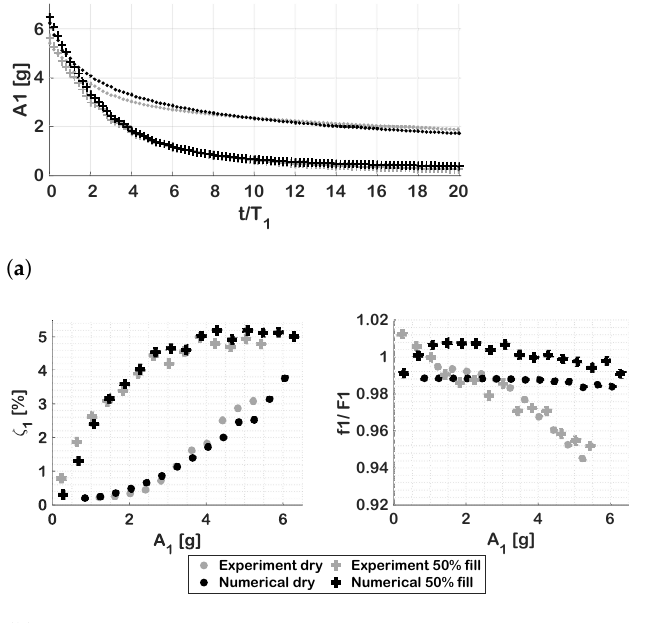
Figure 15. Comparison between experimental and numerical amplitude, frequency and damp- ing ratio of the first bending component: ( a ) amplitude of first bending component versus time; ( b ) damping ratio and frequency versus